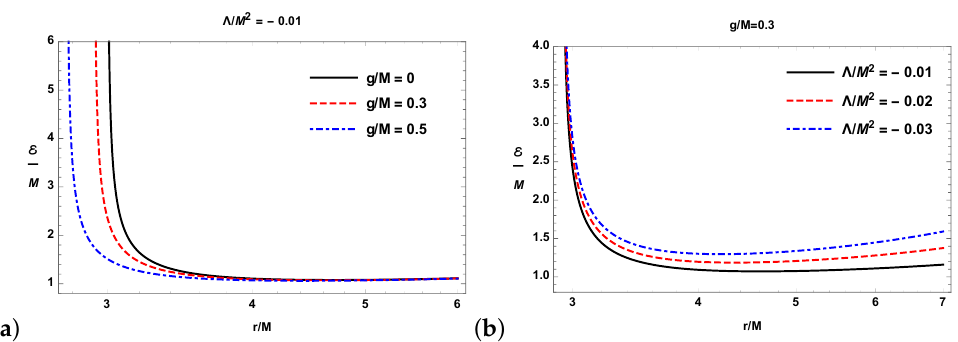
Figure 4. The dependence of the energy of a test particle on circular orbit radius, static regular Bardeen black hole in Anti-de Sitter spacetime. ( a ) for a fixed value of Λ and different values of g . In ( b ) the value of g is fixed for the different values of Λ .